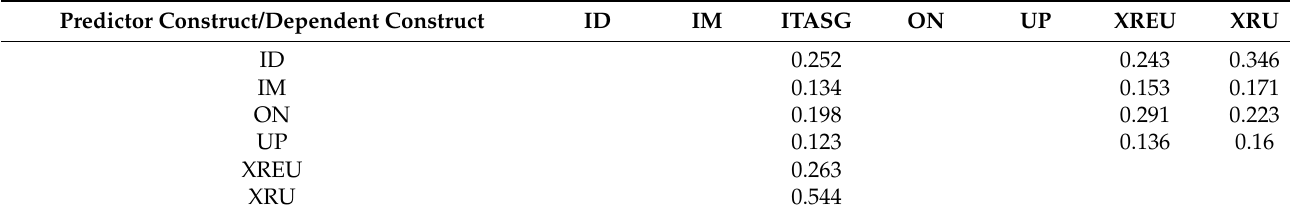
Table 10. Effect Size (f 2 ).